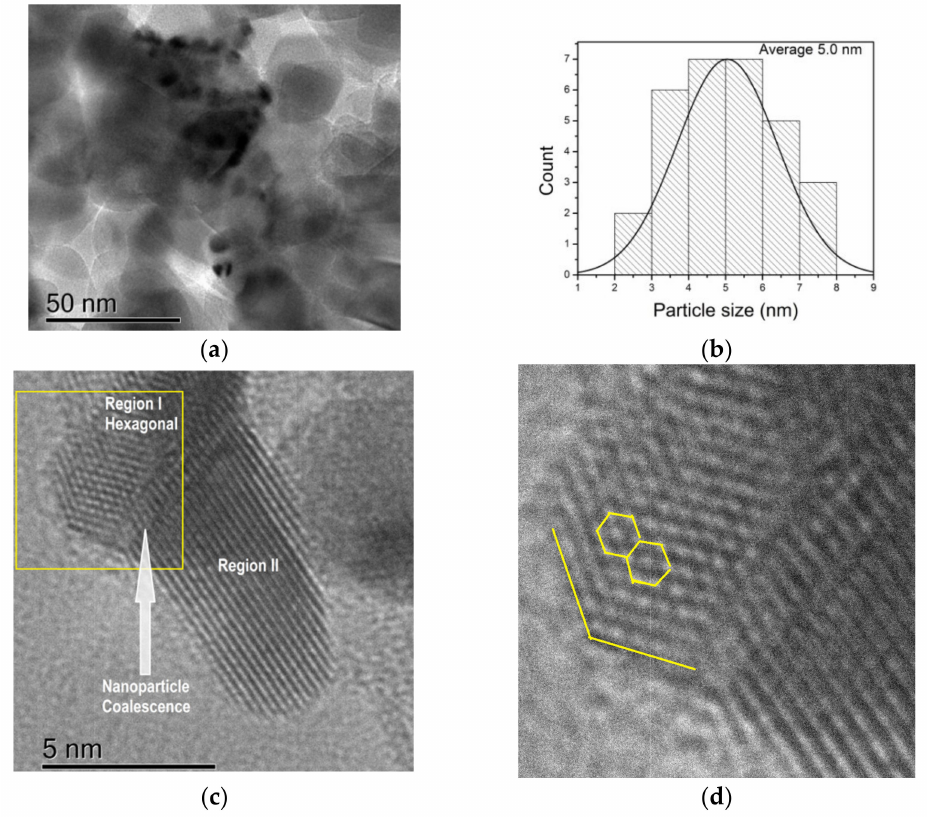
Figure 7. Transmission electron microscopy of platinum nanoparticles: ( a , b ) monodispersed platinum nanoparticles in the 2–8 nm range; ( c ) Pt nanoparticles in coalescence region; ( d ) zoom-in image of Figure 7c and the yellow square showing the